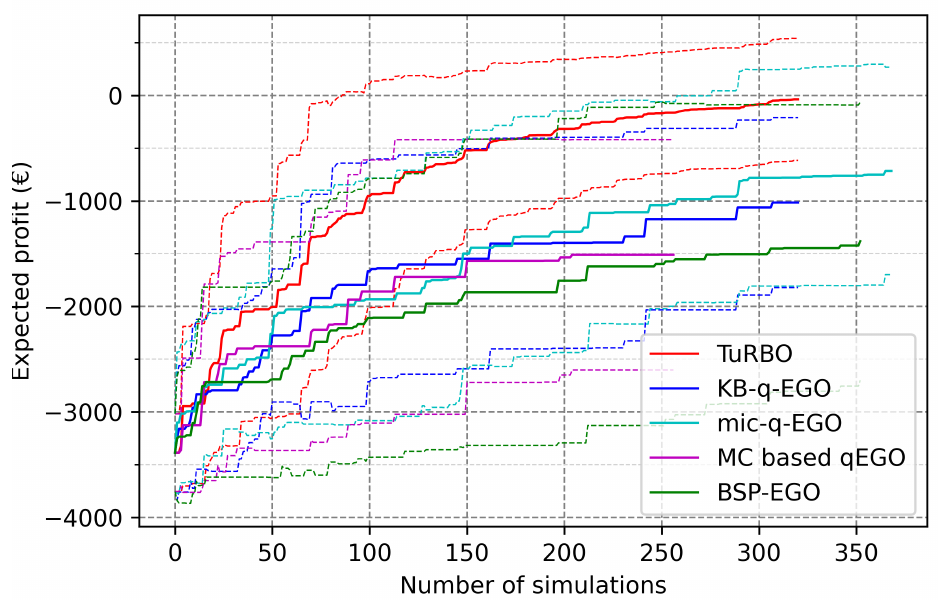
Figure 7. Evolution of the best known objective value according to the number of executed cycles with n batch = 16. Solid lines indicate the average over 10 runs, and dashed lines of same colors indicate the standard deviation.